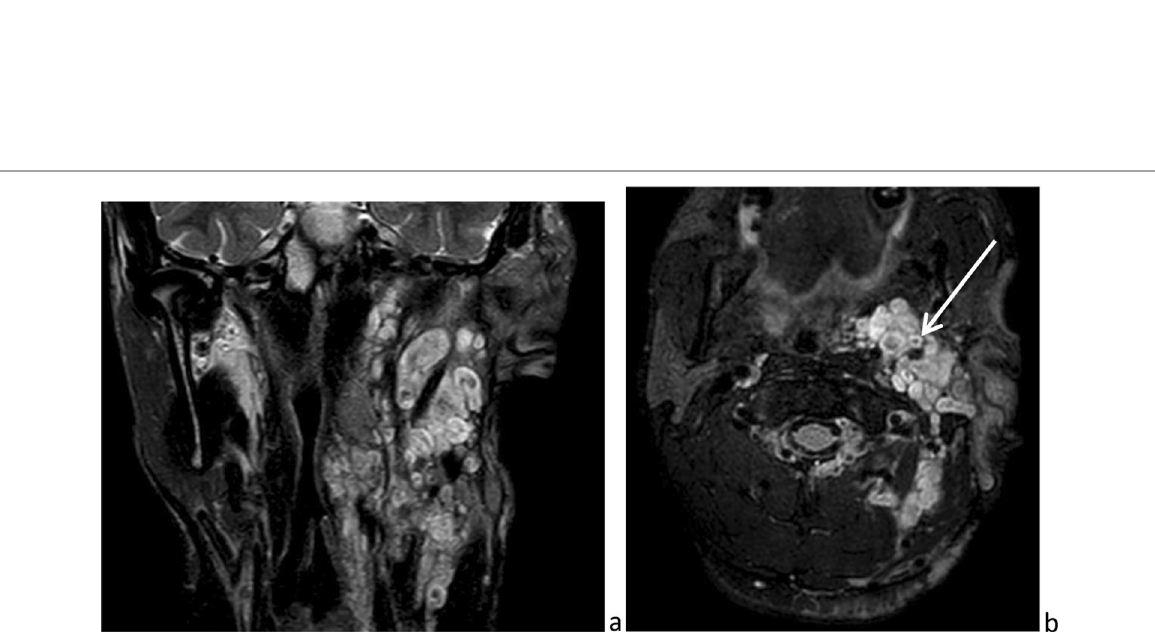
Fig. 15 Neurofibroma, in a child with neurofibromatosis type 1. Frontal and axial T 2 ‑weighted images ( a and b ). Tumor infiltrating the left parotid gland and surrounding spaces. The NF is globally hyperintense (myxoid tissue), with multiple central hyposignals (collagen fibers): “target sign” [white